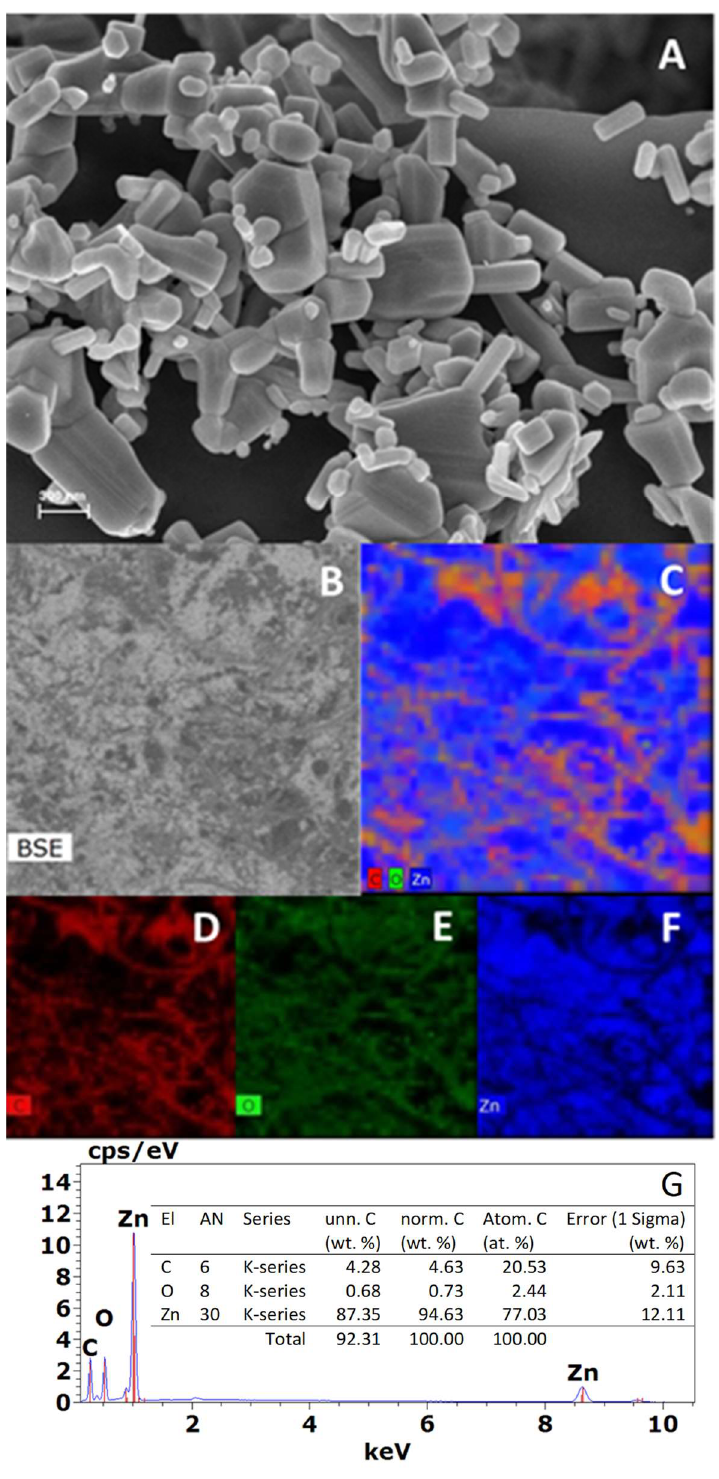
Figure 2. SEM image of SF / ZnO ( A ), back scattered electron (BSE) image ( B ), elemental mapping ( C – F ), and EDX data ( G ) of a SF / ZnO zone.